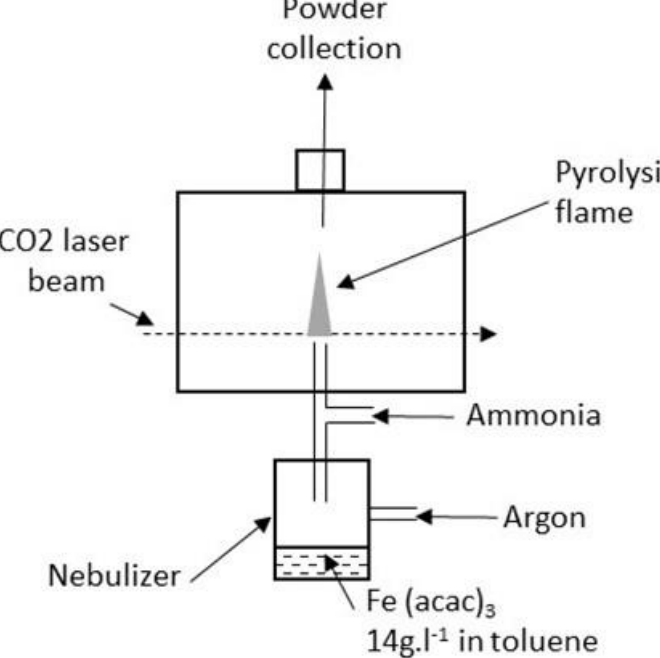
Figure 1. Scheme of the experimental set-up for CO 2 laser pyrolysis.